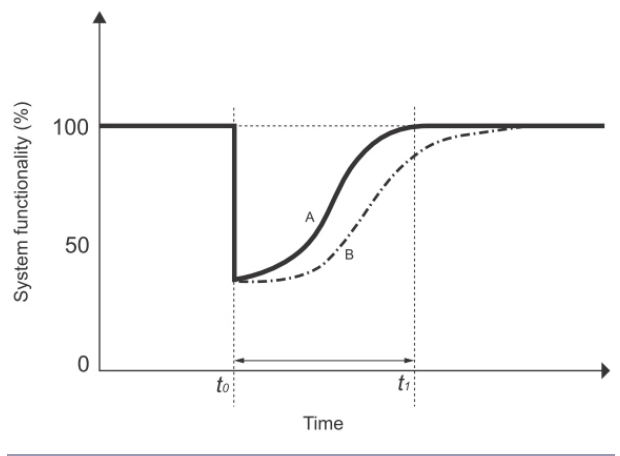
Fig. 1 . A conceptual representation of engineering resilience, modified after Wang and Blackmore (2009). Resilience of a damaged system is measured by the time it takes (t1-t0 for Case A) for the system to recover to 100% of its previous functionality. The longer it takes, the less resilient the system is (Case